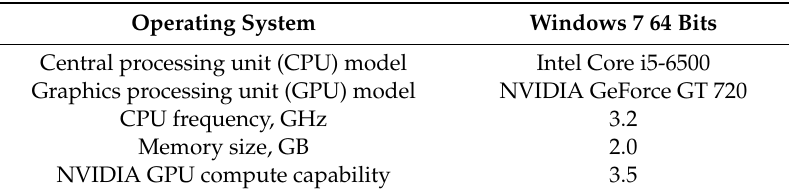
Table 3. Main parameters of the